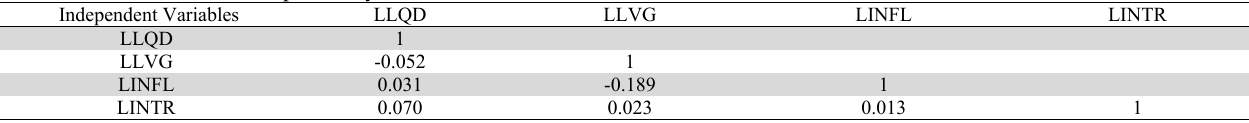
Correlation matrix for the explanatory variables